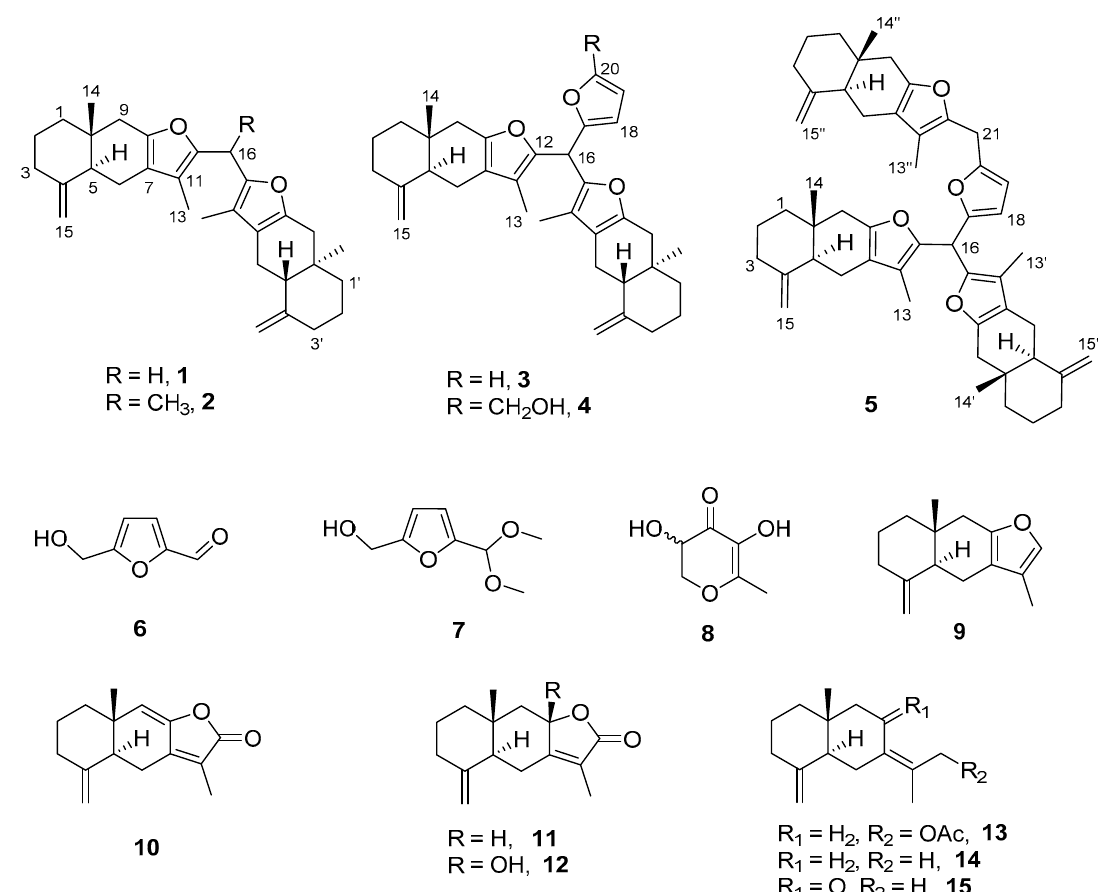
Figure 1. Structures of compounds 1 – 15 .